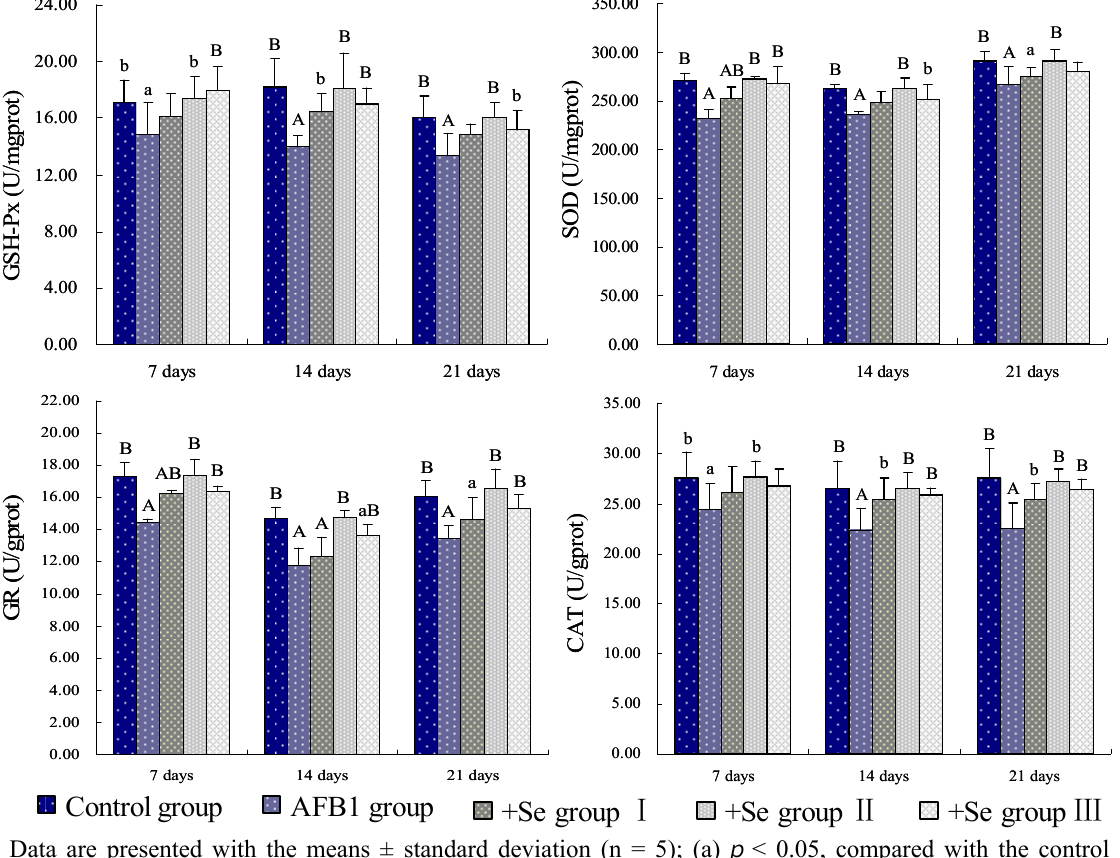
Figure 2. Effect of AFB and Se on the GSH-Px, SOD, GR, and CAT activities of spleen in 1